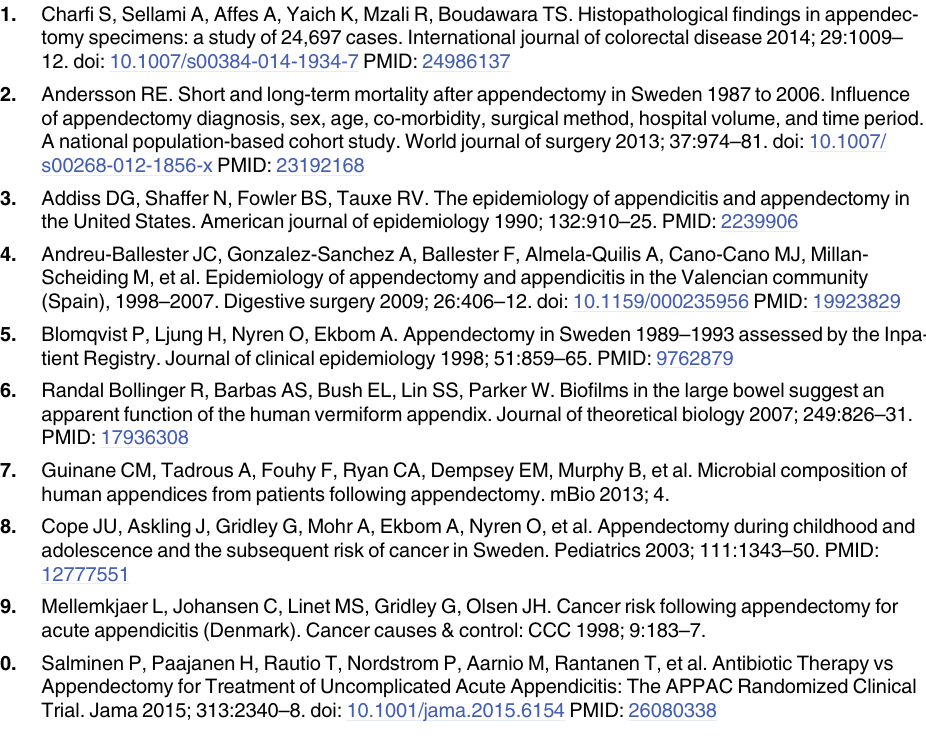
S1 Table. Sensitivity analysis: Standardized incidence ratio (SIR) and 95% confidence inter- vals (CIs) for gastrointestinal cancers in the appendectomy cohort, 1987 –